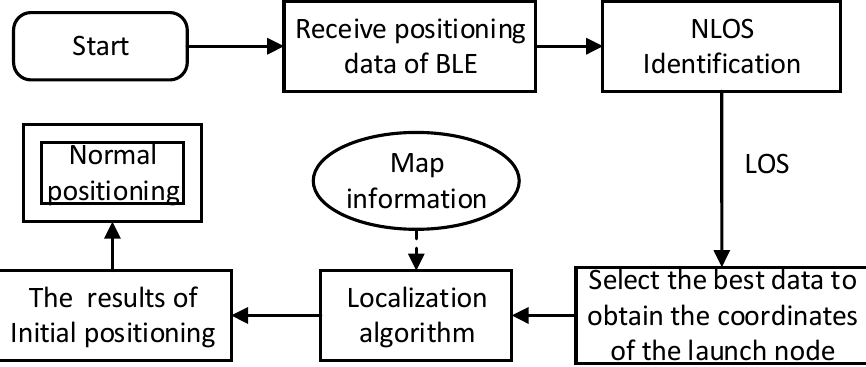
Figure 2. The process of the initial positioning.